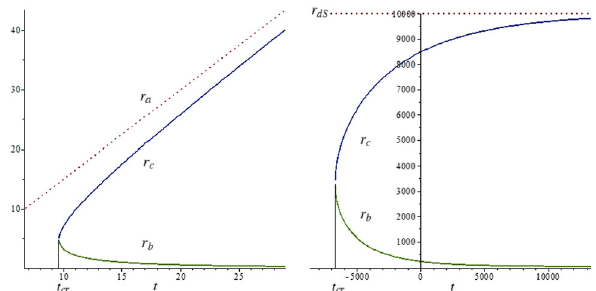
Fig. 1 Fold-type,orC-curve,evolutionofthedynamicalhorizonsaris- ing at the critical time t cr in the matter-dominated universe (left panel) and de Sitter expanding universe (right panel). The cosmological hori- zons tend to the apparent horizons of the asymptotic FLRW space-times while the black hole horizons collapse dynamical particle does not have horizons for t < t cr but when t > t cr the cosmological and black hole dynamical horizons evolves as in the left panel of Fig. 1. The cosmo- logical horizon of radius r c ( t ) approaches asymptotically to the apparent horizon of ( M , a ) which is a sphere of radius t expanding with the constant velocity v a = 3 r a ( t ) = 3 2